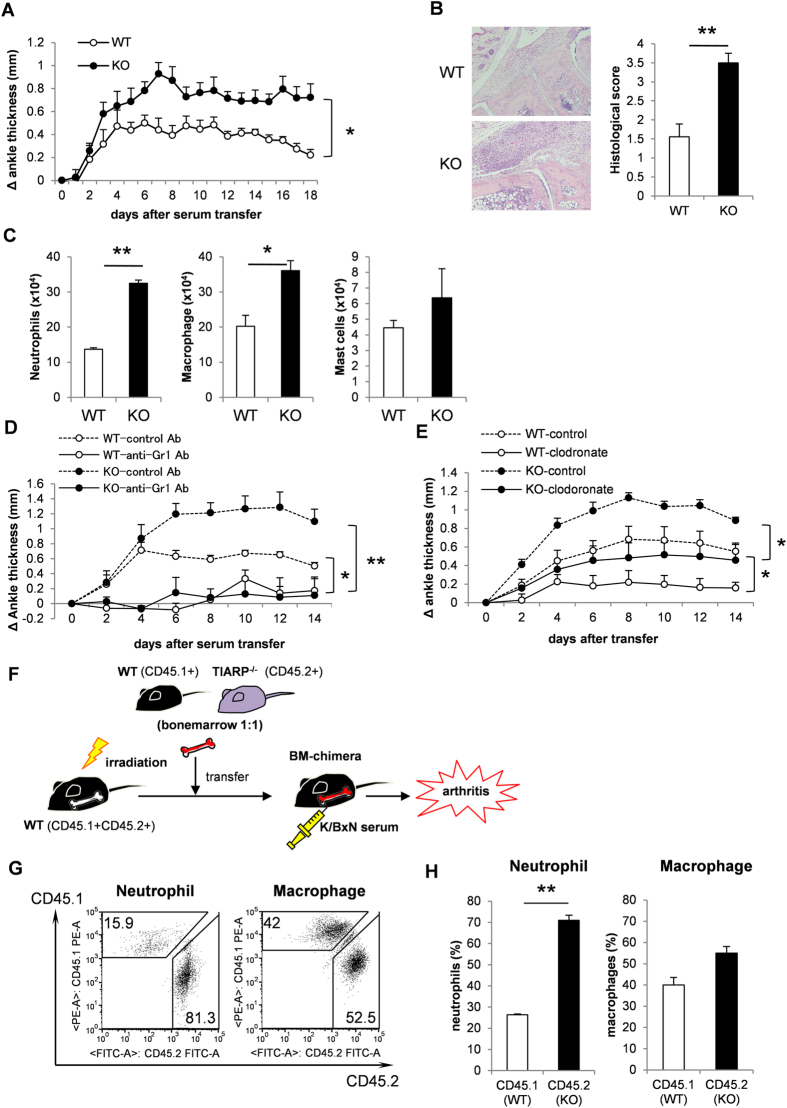
Development of K/BxN serum-induced arthritis in mice.For induction of arthritis, 50 μl of K/BxN serum was injected intraperitoneally on days 0 and 2. (A) Delta (⊗-) ankle thickness (mm). Data were obtained from two independent experiments involving WT mice and TIARP−/− mice (n = 13, each). (B) Hematoxylin and eosin (H&E) stained sections of the ankle joints after induction of arthritis. Original magnification x100. Inflammation scores in WT and TIARP−/− mice after induction of arthritis. (C) Numbers of neutrophils, macrophages and mast cells in the ankle joints determined on day 14. (D) Mice were administered arthritogenic K/BxN serum and either isotype control (rat IgG2b) or anti-Gr1 mAbs (RB6-8C5). The dose of mAbs was 200 μg per injection every 2 days throughout the experiment. (E) Changes in ankle thickness in clodronate liposome- and control liposome-treated WT and TIARP−/− mice. Data are representative of two independent experiments. (F) Experimental scheme. Neutrophils from WT (CD45.1+) and TIARP−/−(CD45.2+) bone marrow were adoptively transferred with each cells intravenously into WT (CD45.1+ CD45.2+) mice, which was treated with K/BxN serum on day 2. (G,H) Frequency of migrated neutrophils and macrophages in the joint after 6hrs of serum transfer were detected by flow cytometry. Data are mean mean ± SEM. *P < 0.05, **P < 0.01.